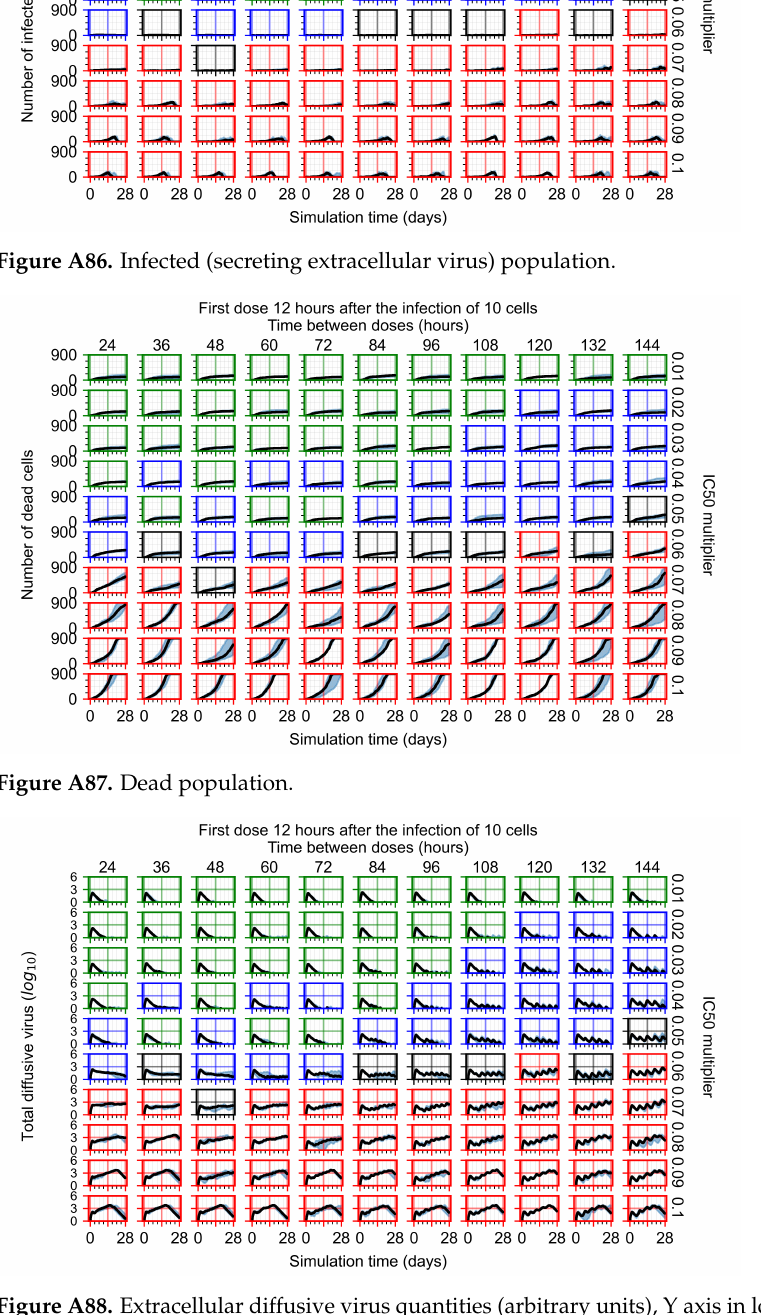
Figure A88. Extracellular diffusive virus quantities (arbitrary units), Y axis in log scale, and exponent values as tick